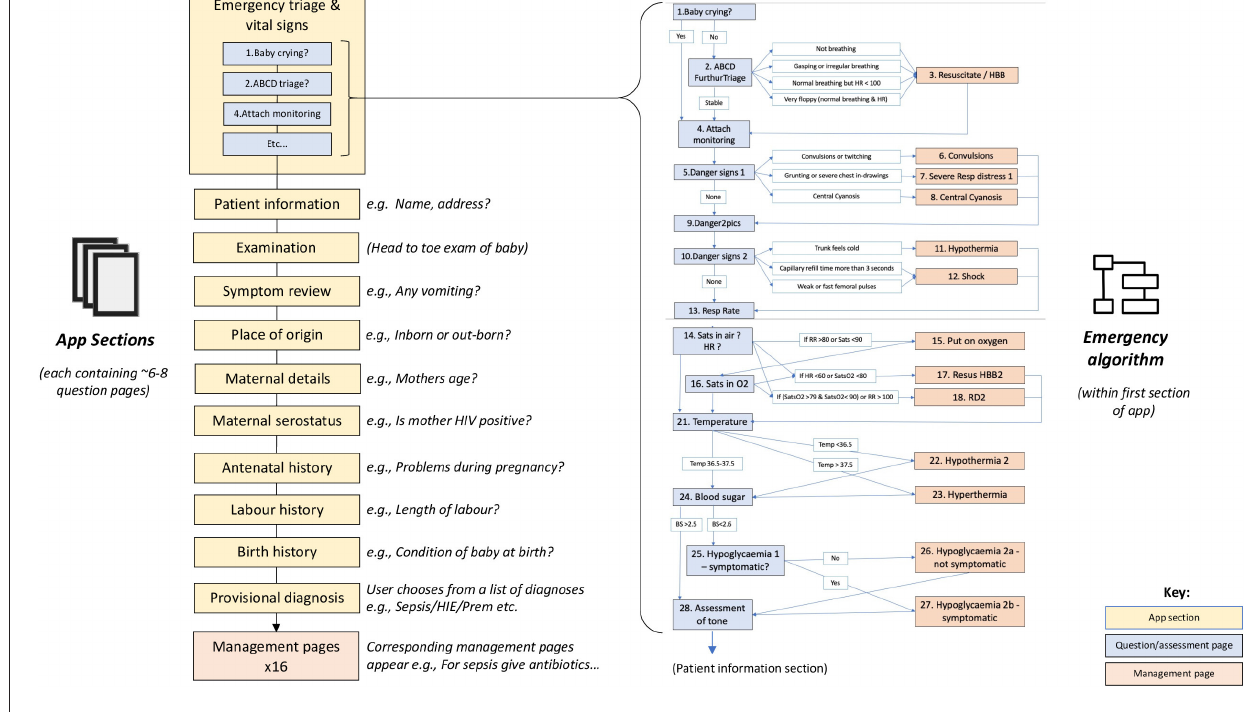
FIGURE 2 | Map of NeoTree App.